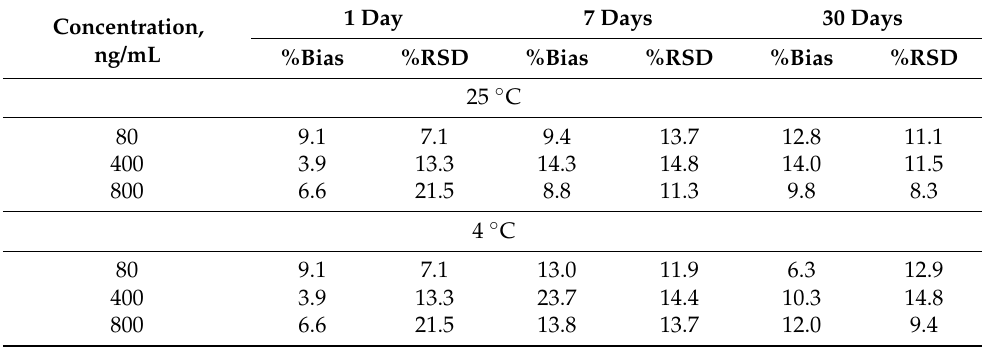
Table 3. Stability of atenolol in DPS at 4 and 25 ◦